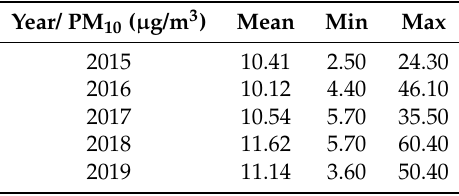
Table 10. PM 10 statistic during 2015–2019 years.